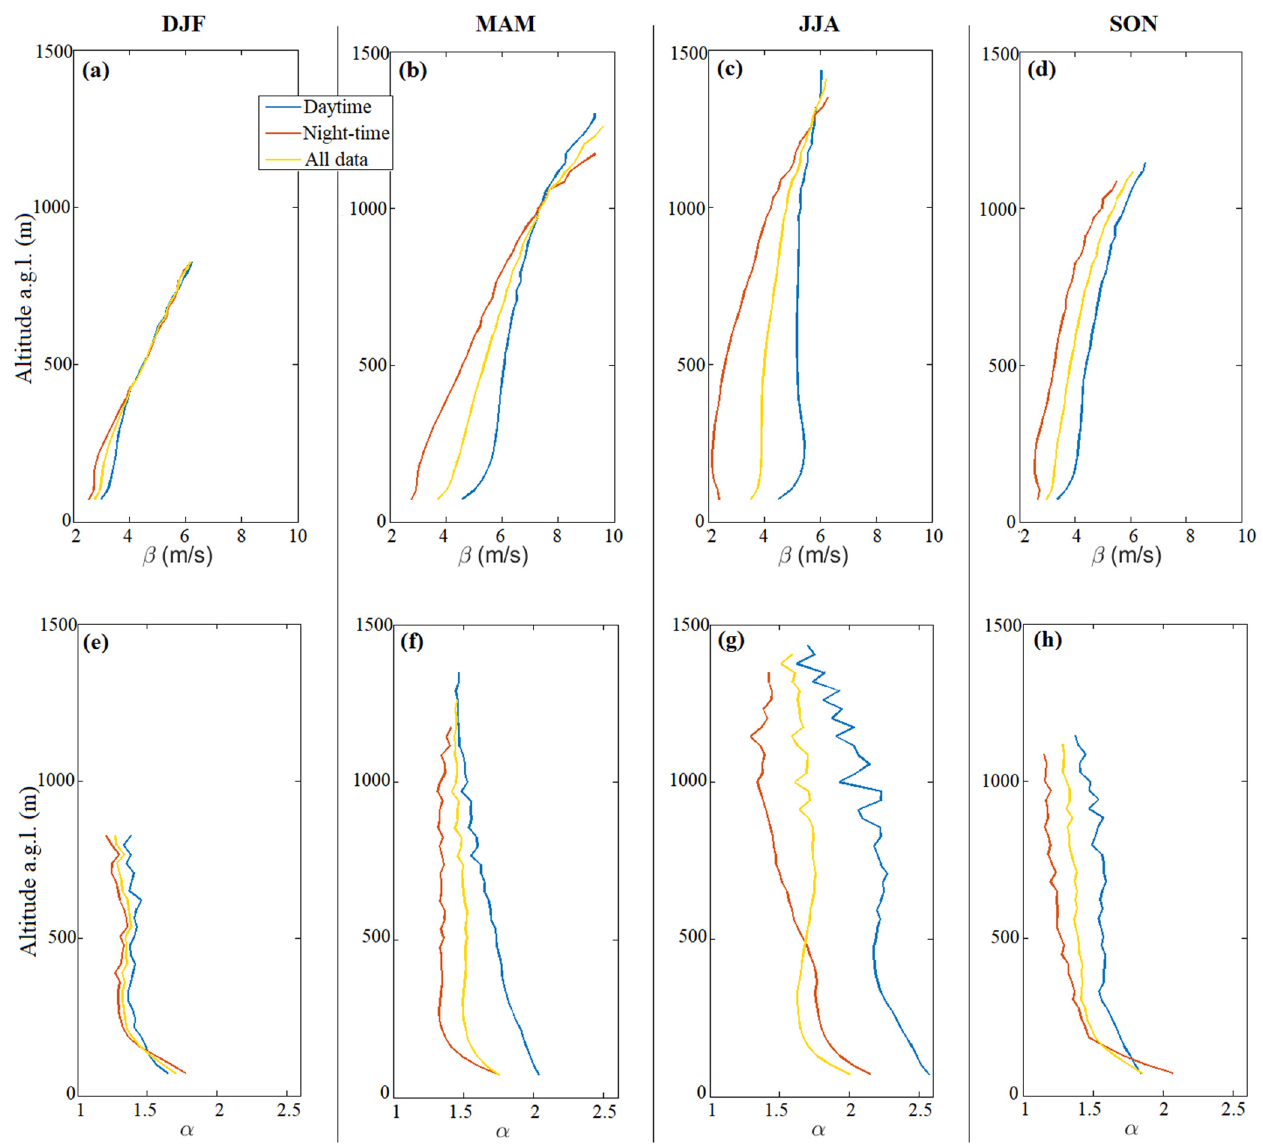
Figure A1. Weibull scale ( a – d ) and shape ( e – h ) parameter profiles calculated for the different seasons for all data (yellow), only daytime data (blue) and only night-time data (orange).